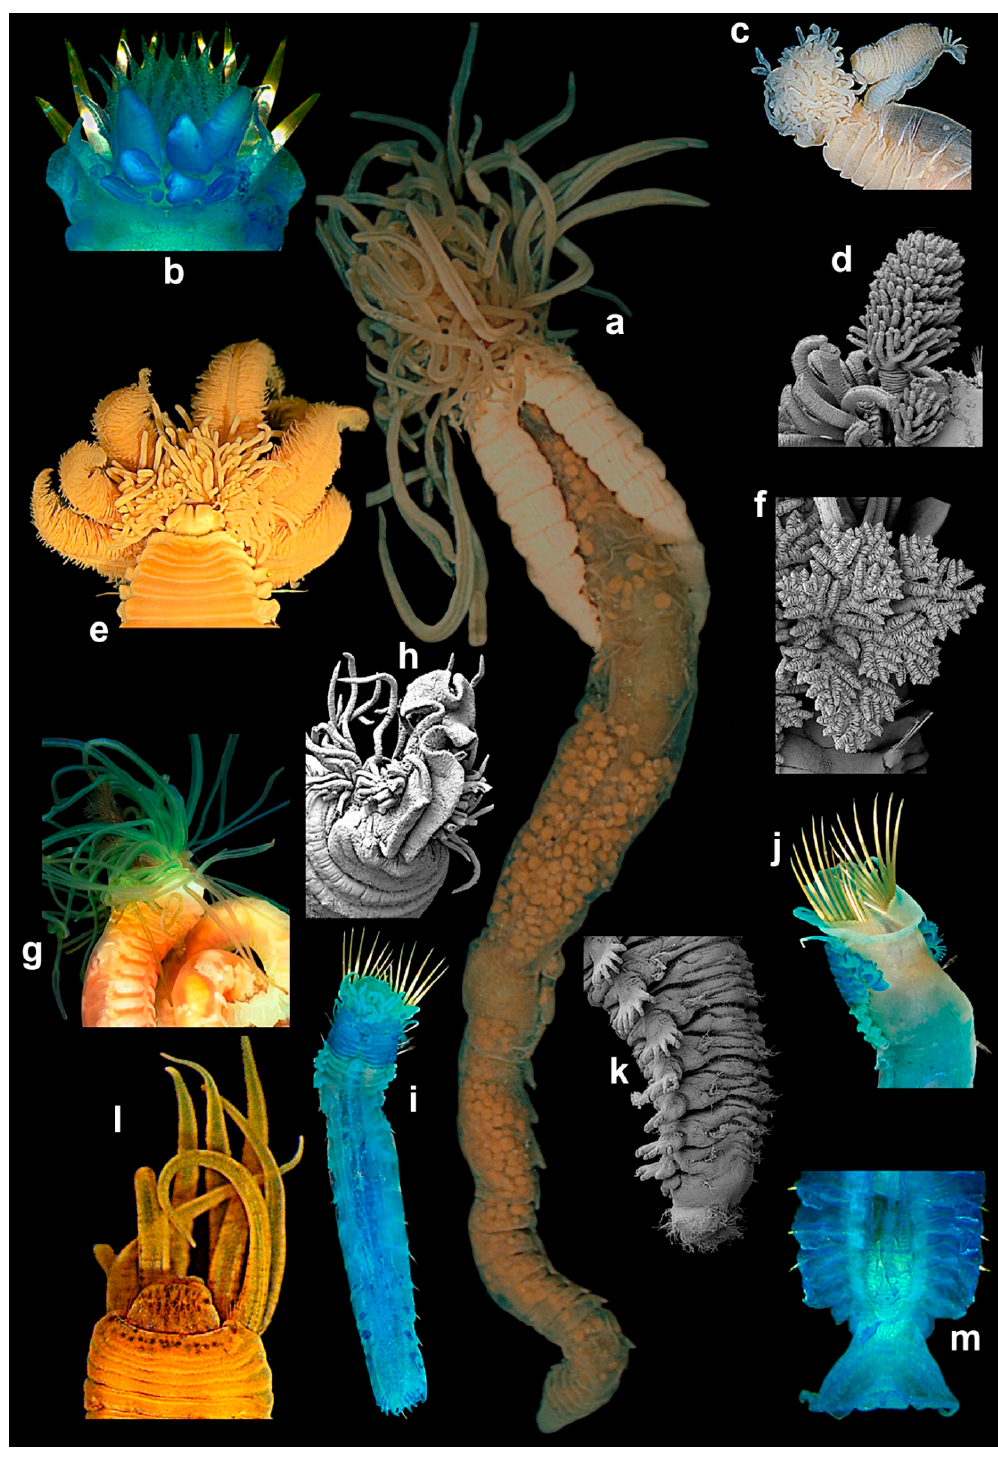
Figure 5. Diagnostic characters of terebelliforms: ( a ) Nicolea lazowasemi (holotype YPM 40593) (TER): entire worm, a gravid female, dorsal view; ( b , m ) Pectinaria antipoda (stained in methyl green) (PE): anterior and posterior ends, ventral views, respectively; ( c ) Terebellides akares (NTM W.023143) (TR): left lateral view; ( d ) Pistella franciscana (paratype AM W.44593) (TER): detail of branchiae (SEM); ( e ) Alvinella pompejana (AM W.29585) (AL): anterior end, ventral view; ( f , g ) Pista chloroplokamia (TER): detail of a branchia (SEM) and anterior end of live animal, right lateral view, respectively; ( h ) Rhinothelepus occabus (paratype AM W.201904 (TE): detail of oral area as shown by SEM; ( i , j ) Petta investigatoris (stained in methyl green) (PE): entire worm, ventral view, and anterior end, left dorso-lateral view, respectively; ( k ) Trichobranchus hirsutus (paratype AM W.47510) (TR): posterior end examined under SEM; ( l ) Amphicteis dalmatica ( AM): anterior end, ventral view.